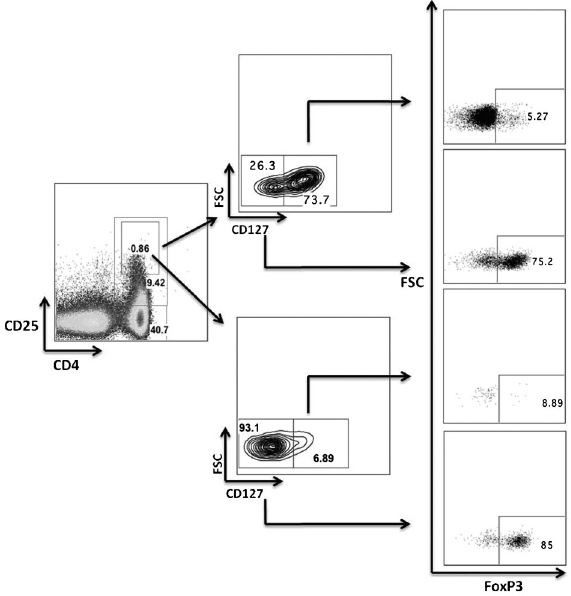
Figure 1. Multi-parameter strategy of analysis to identify TREG cells. A representative healthy control sample was analyzed by flow cytometry according to the expression of CD4, CD25, CD127, and FoxP3. CD25 + and CD25 high cell subsets presented distinct frequency of CD127 Ø/low cells and in both subsets the CD127 Ø/low phenotype was associated with high FoxP3